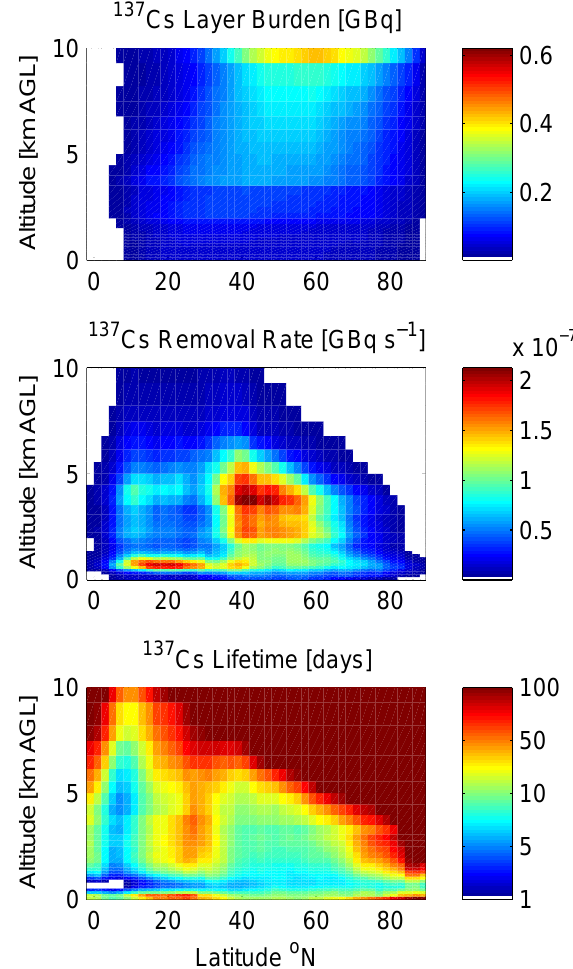
Fig. 5. Zonal, 4-month mean 137 Cs layer burdens (top panel), zonal, 4-month mean 137 Cs wet removal rates (middle panel), and zonal, 4-month mean 137 Cs lifetimes ( τ 4mo ) with respect to wet de- position (bottom panel). All zonal means are taken over the final four months of the simulation